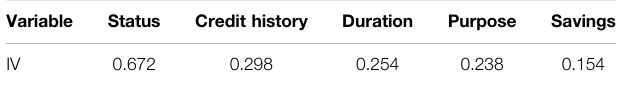
TABLE 2 | Information values of the scorecard variables and the removed variable personal status and sex.